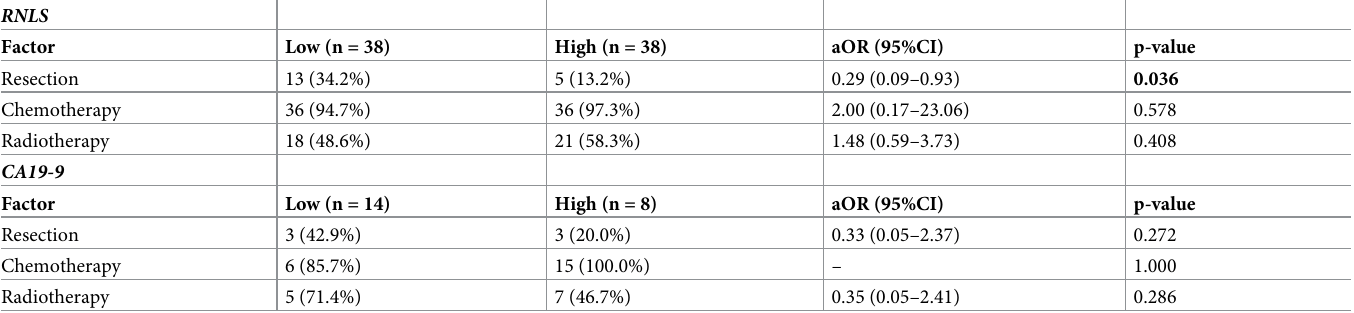
Table 5. Treatments for high vs. low RNLS levels in patients with locally advanced/borderline resectable pancreatic adenocarcinoma as compared to CA19-9.